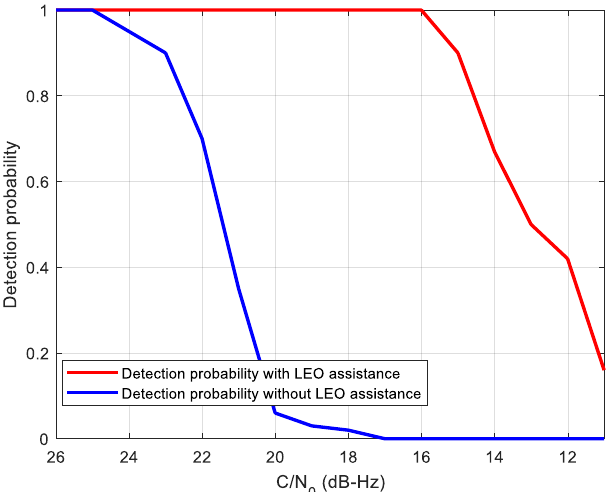
Figure 14. Acquisition performance comparison between LEO-assisted and unassisted method.